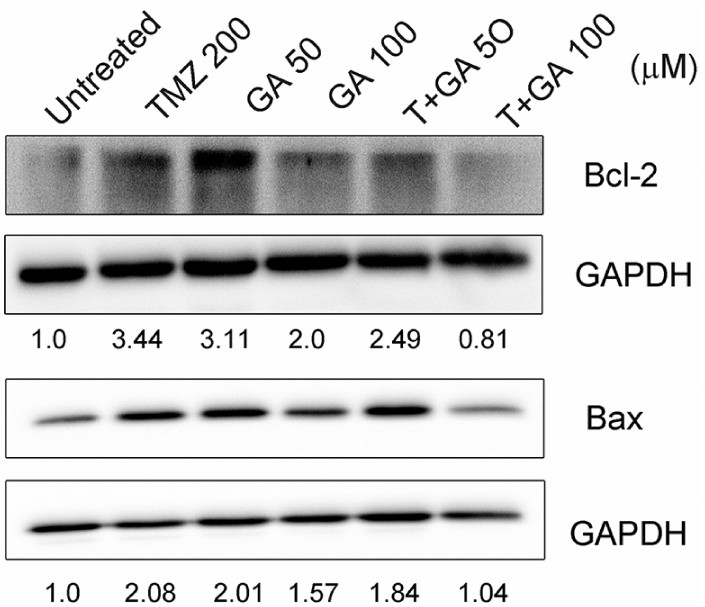
Figure 4. Expressions of Bcl-2 and Bax with TMZ, Ga or Ga/TMZ treatment. U87MG cells were cultured in 6 cm cultured dishes for 24 h and then incubated with 200 µ M TMZ, 50 or 100 µ M Ga, or co-incubated with both for 48 h. After incubation, whole proteins were extracted. The expressions of Bcl-2 and Bax were detected by Western blotting. Experiments were performed at least 3 times; an illustrative experiment was revealed. Numbers show the densitometric data of various incubated cellular groups normalized to their related untreated group.